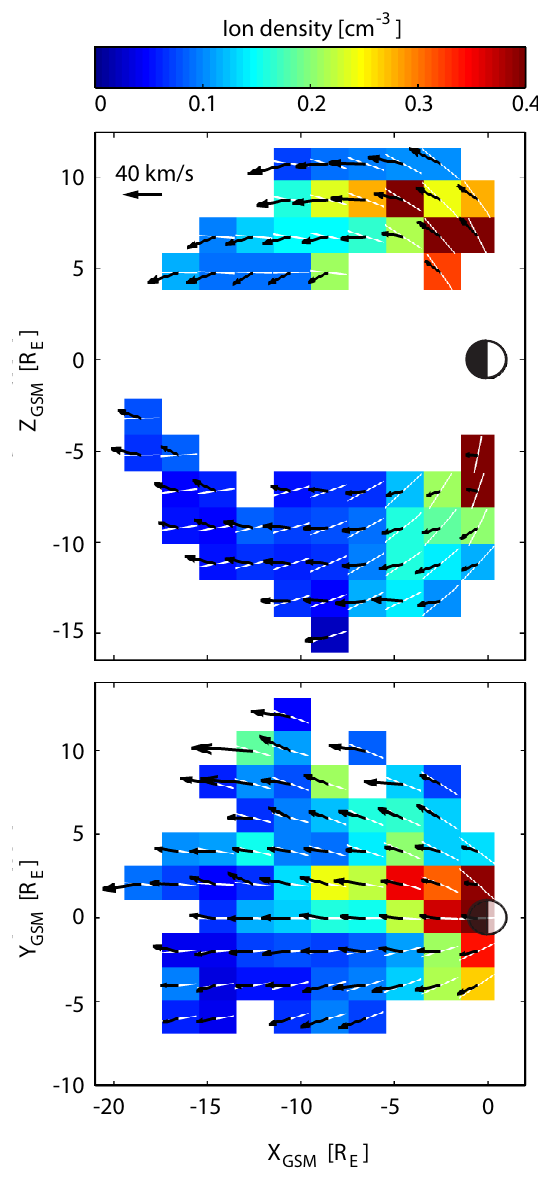
Fig. 7. Density and velocity maps. The mean density and velocity are shown in the GSM X - Z and X - Y planes. The data are grouped in 2 R E by 2 R E bins. A bin is coloured if the number of points in the bin exceeds approximately 350 (30% of the mean number of points in a bin). The direction of the magnetic field is shown in white. (The total data set consists of 180000